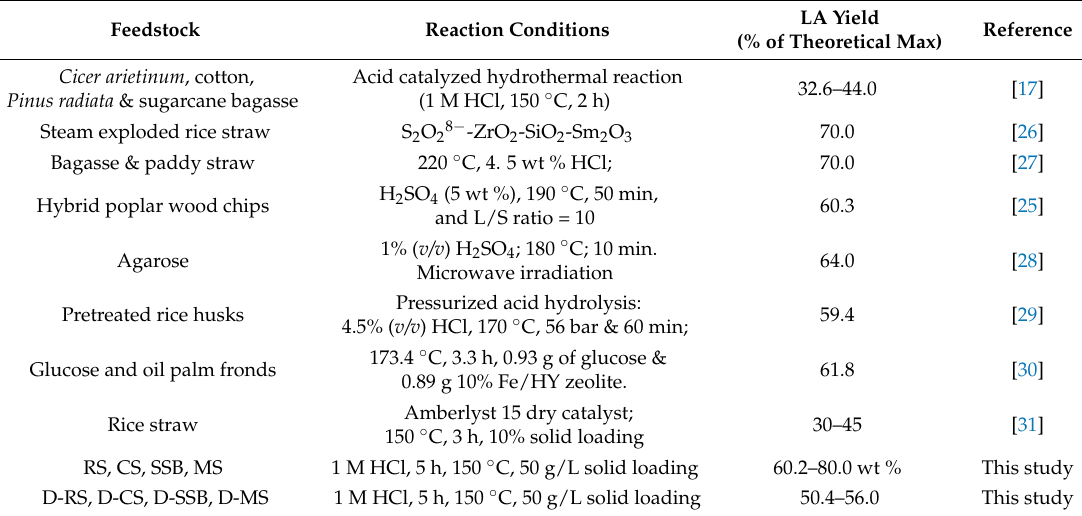
Table 2. Developments in the production of LA from